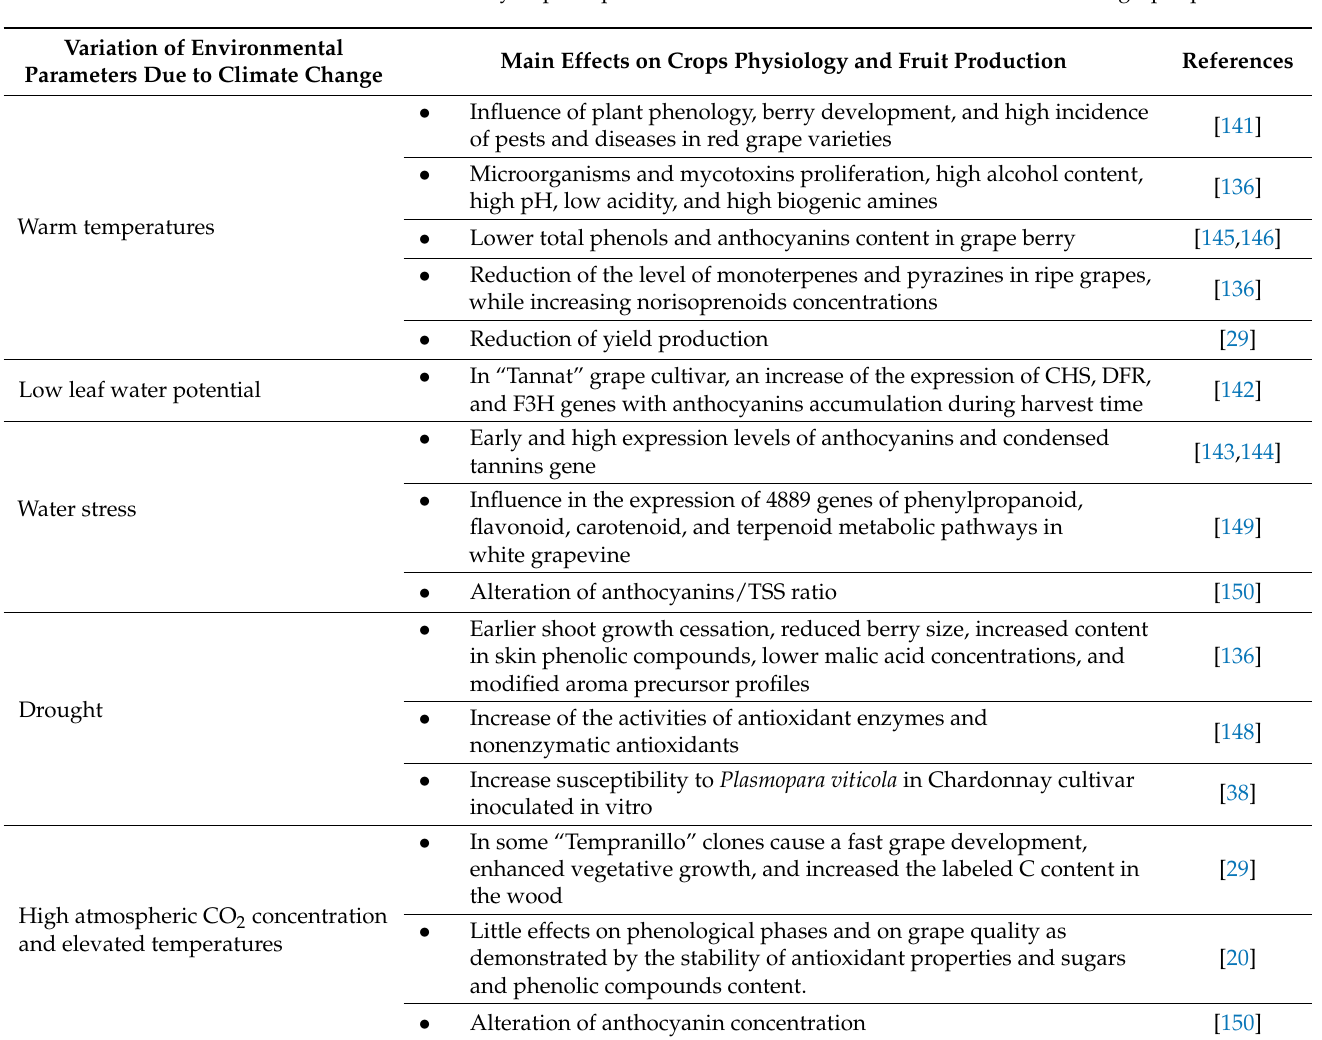
Table 4. Summary of principal effects of environmental conditions variation on grape